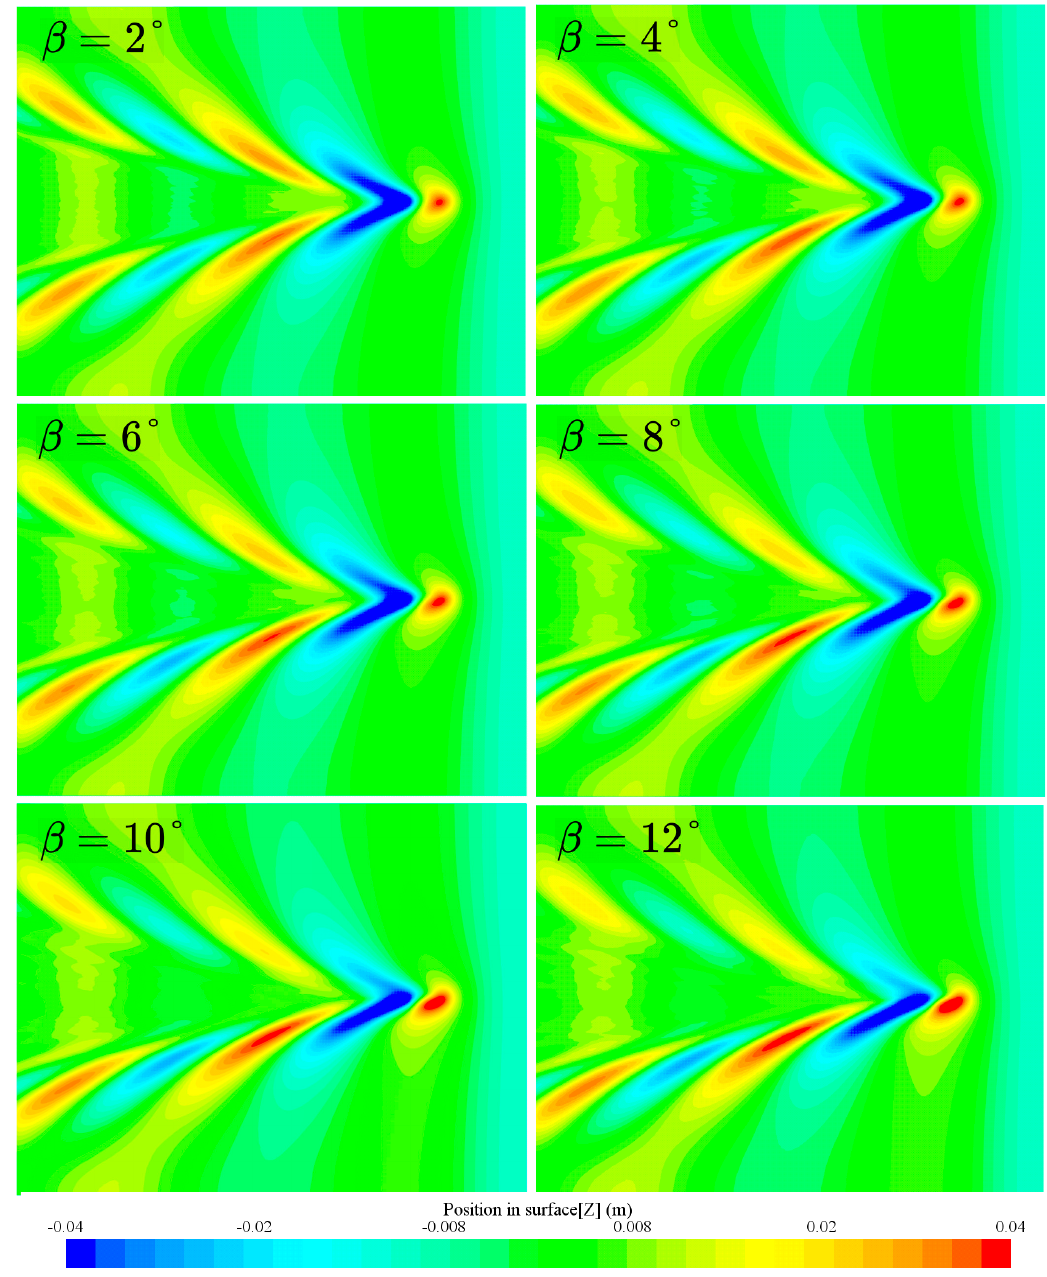
Figure 12. Free surface wave wake at different drift angle.